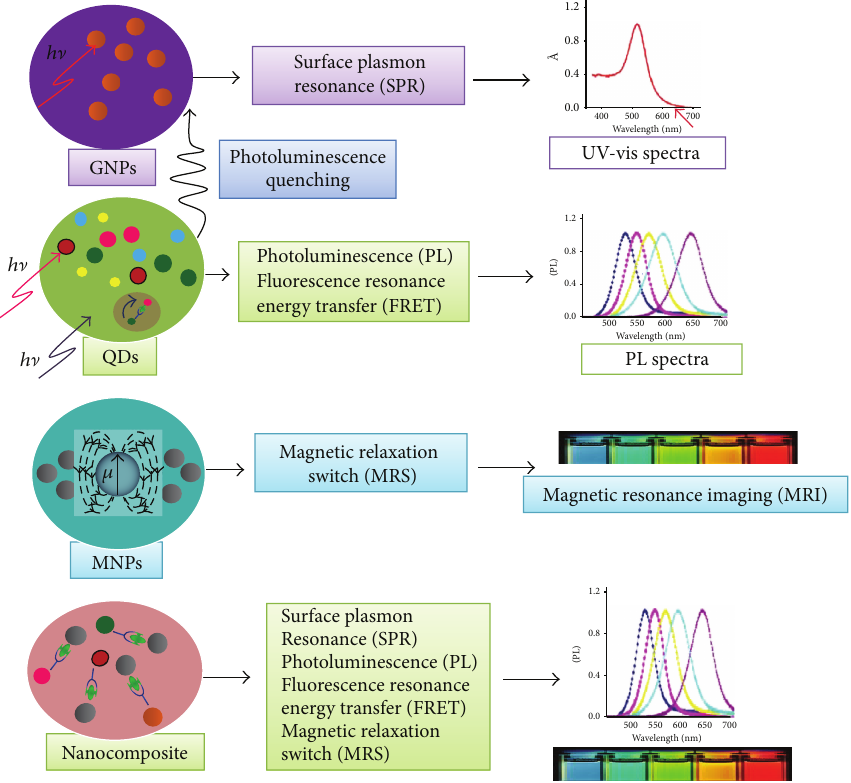
Figure 1: Schematic diagram illustrating different nanoparticles conferring optical (e.g., gold nanoparticles (GNPs)), fluorescence (e.g., quantum dots (QDs)), and magnetic (e.g., magnetic nanoparticles (MNPs)) properties, and combinations between these particles as nanocomposites conferring multifunctionalities provide distinct advantages for environmental